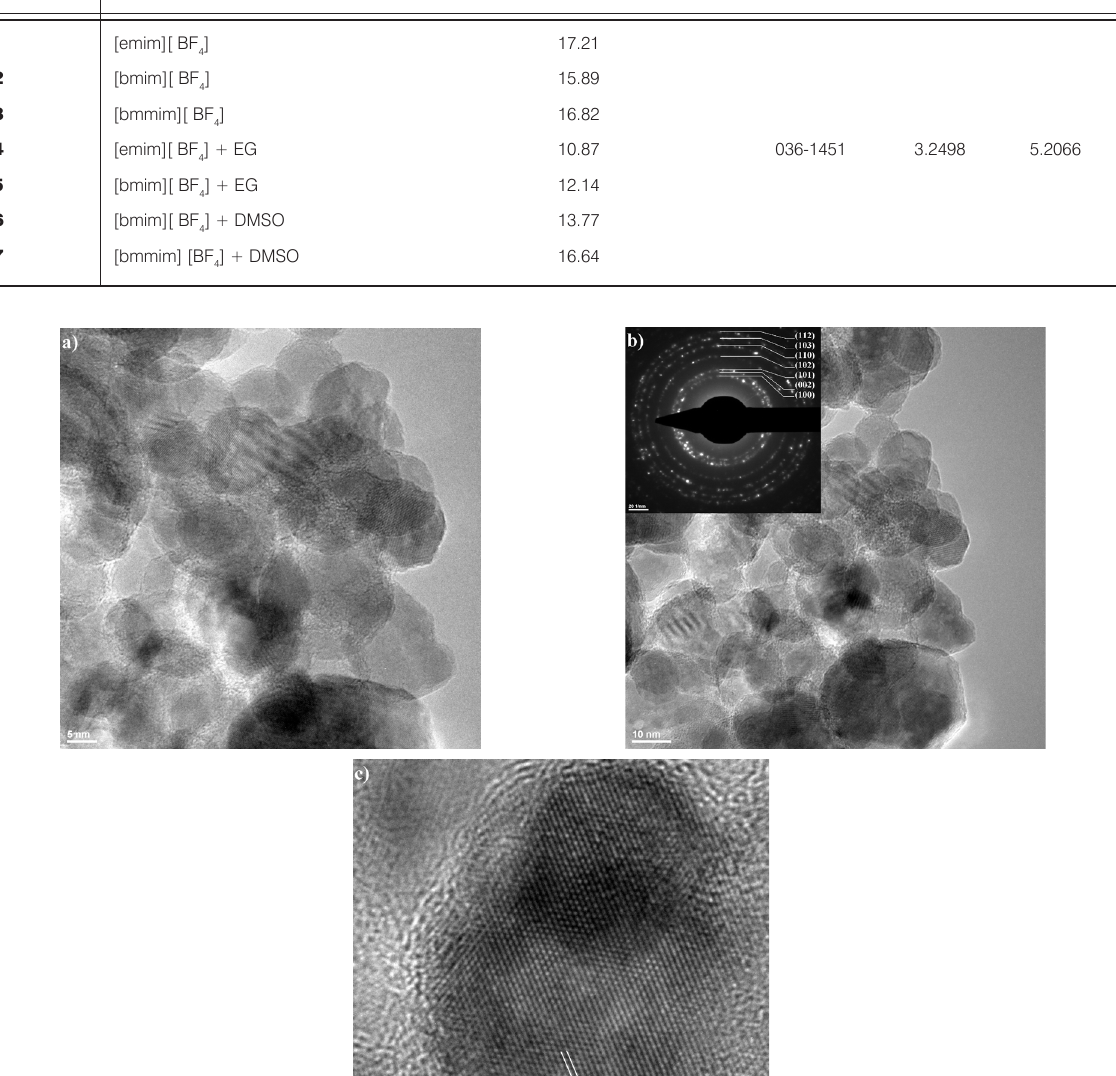
Table 3. The average crystallite size of ZnO obtained in ionic liquids media.